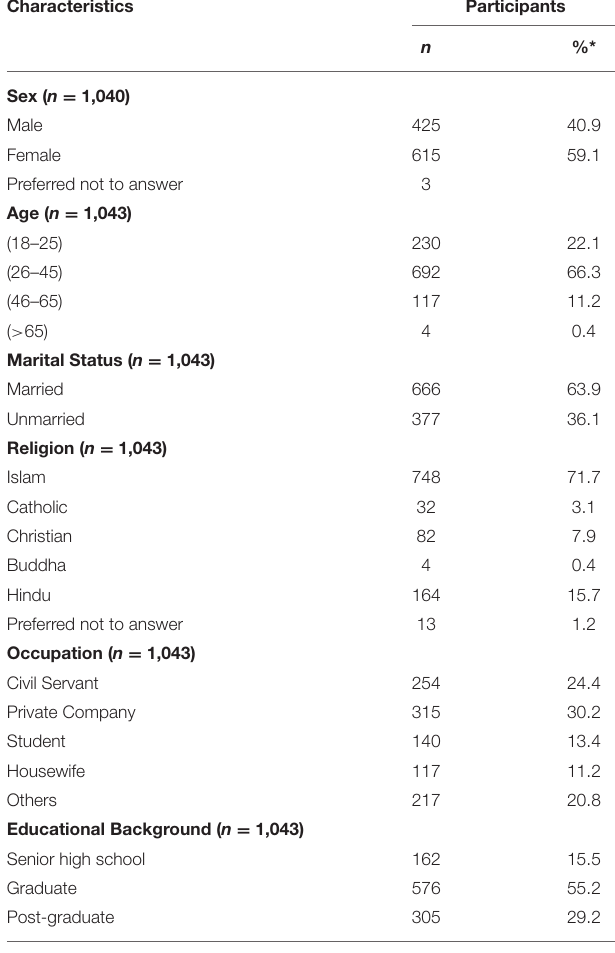
TABLE 1 | Sociodemographic characteristics of the respondents ( N =